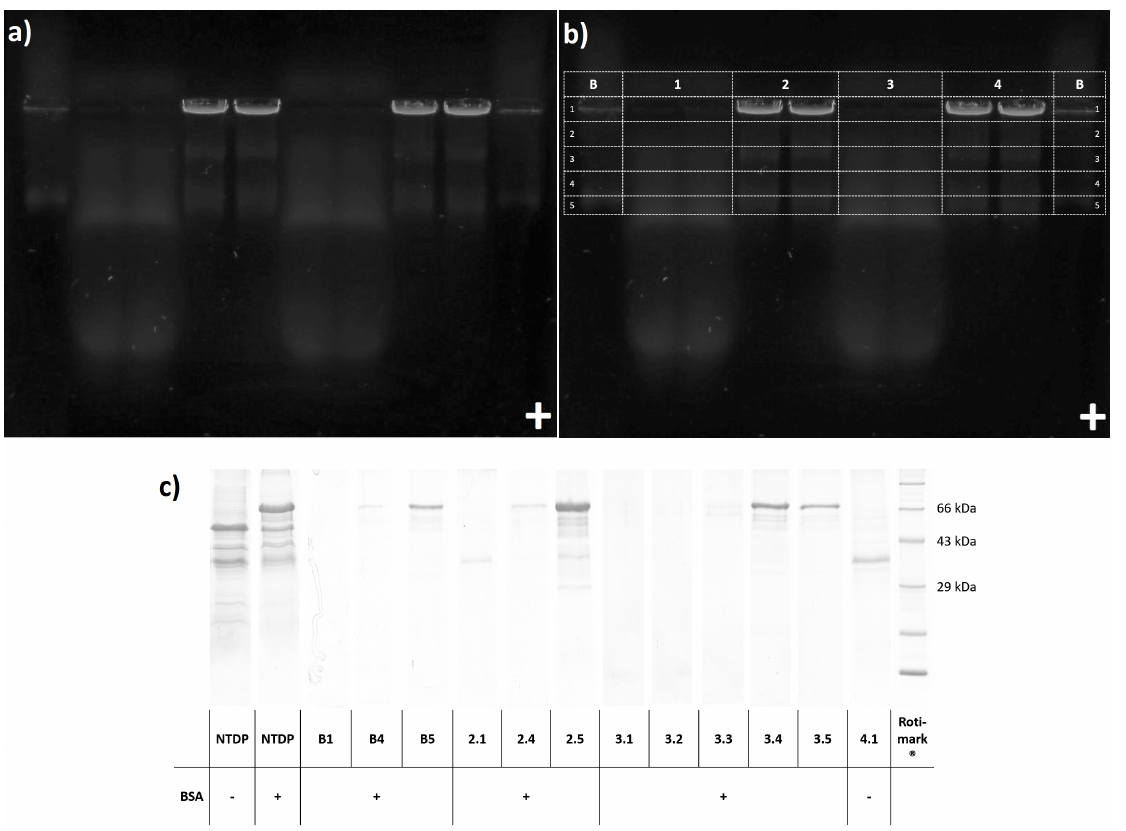
Figure 4. ( a ) agarose gel of dried N. tabacum 50,000 × g pellet (NTDP) and supernatant (NTDS) with and without BSA added, and BSA-blank (for application order see b) at 254 nm with 530 nm band filter ( b ) pattern of agarose gel slicing: B- BSA-blank(DiOC 6 +BSA) 1- NTDS 2- NTDP+BSA 3- NTDS+BSA 4- NTDP ( c ) SDS PAGE of NTDP, NTDP+BSA, and NTDS before and after agarose gel electrophoresis (selected agarose gel slices after TCA